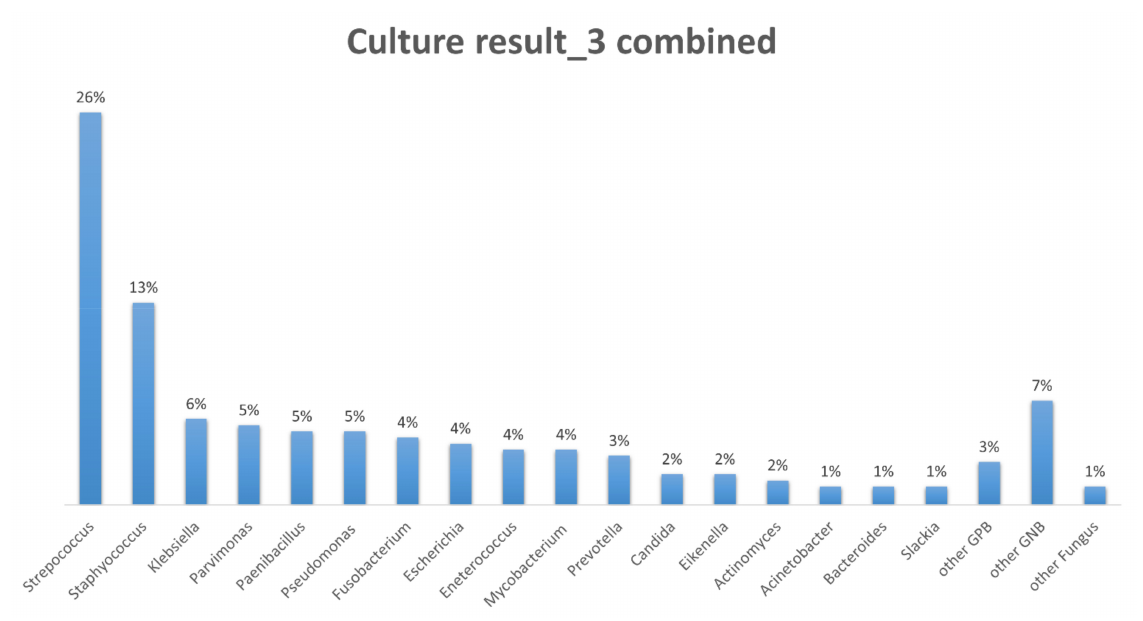
Figure 2. The distribution of the pathogens. Streptococcus (26%) and Staphylococcus (13%) are the most common species of pathogens in empyema.